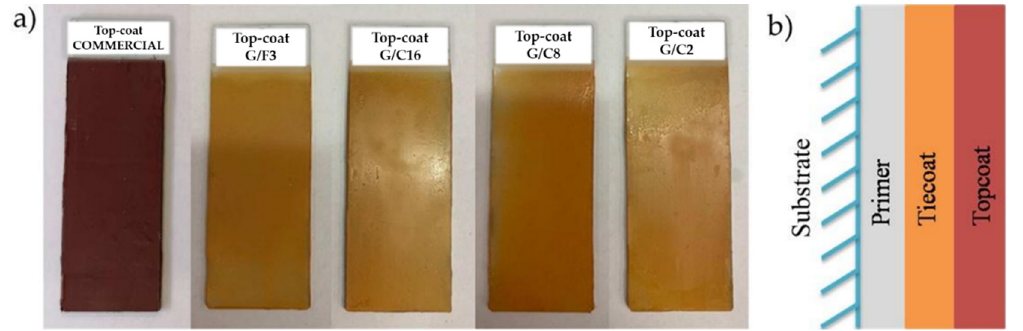
Figure 4. Images of different coating as deposited on the microscope slides ( a ); schematic summary of the individual layers ( b ).